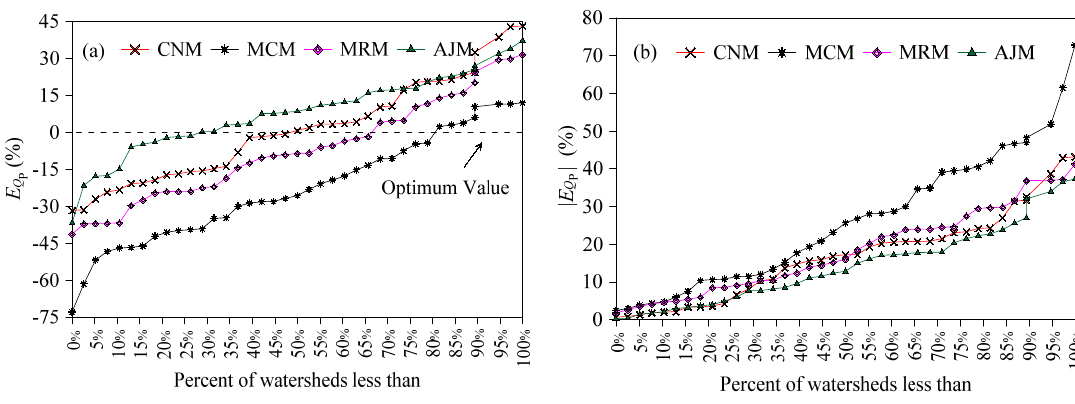
Figure 8. Model evaluation for 39 watersheds based on: ( a ) cumulative distribution of percentage error in peak discharge ( E Q ), and ( b ) cumulative distribution of absolute percentage error in peak discharge | E |.